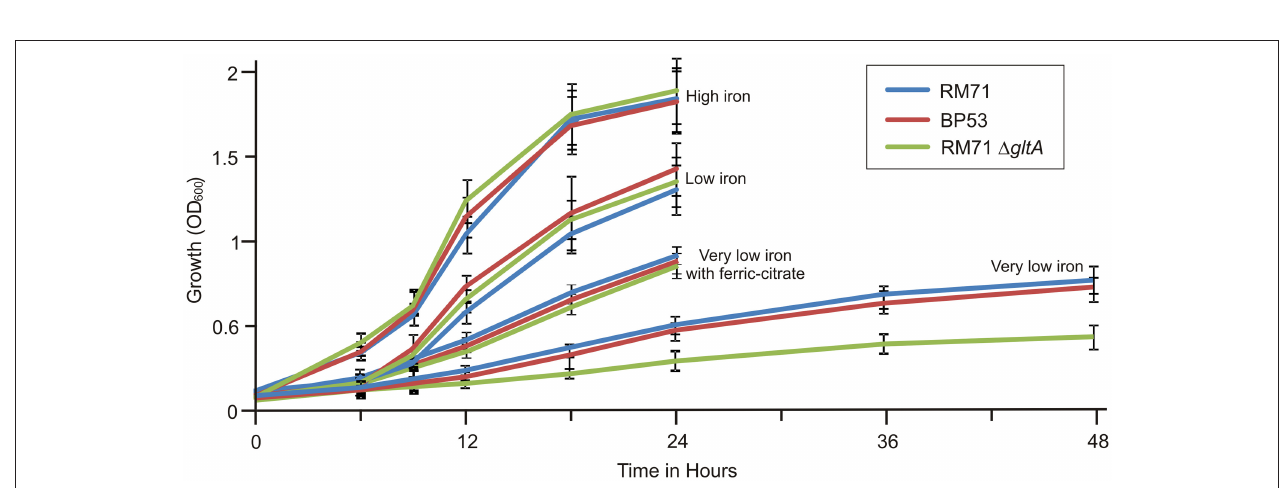
FIGURE 2 | Growth curves of RM71 and mutants BP53 and RM71 1 gltA under different iron conditions. High iron: CM9 supplemented with 10 µ M Fe 2 (SO 4 ) 3 ; low iron: CM9 plus 40 µ M 2,2 ′ -dipyridyl; very low iron: CM9 plus 75 µ M 2,2 ′ -dipyridyl. Each point represents mean values from three replicates. Error bars indicate standard